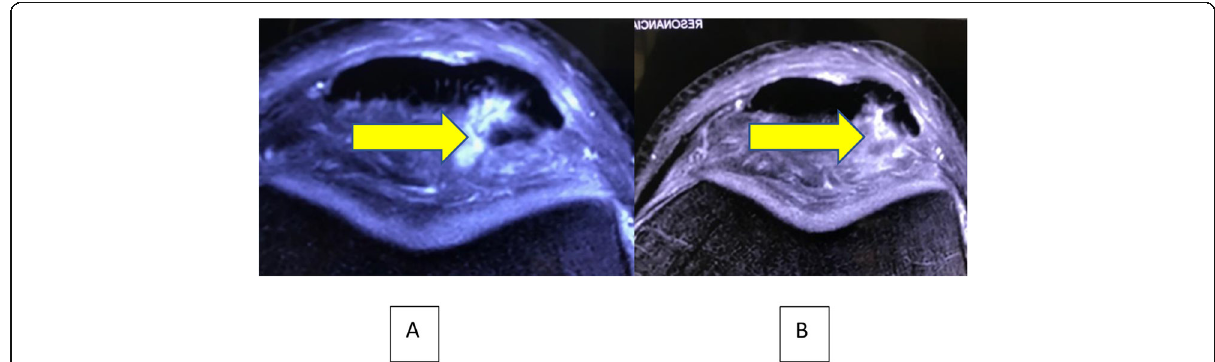
Fig. 8 A Pre-injection axial STIR MR image showing injury of the patellar tendon and B : 6 months Post-injections axial view MRI showing partial healing of the tendon. Observe Fat Pad Edema decreasing over a 6 months period. Yellow